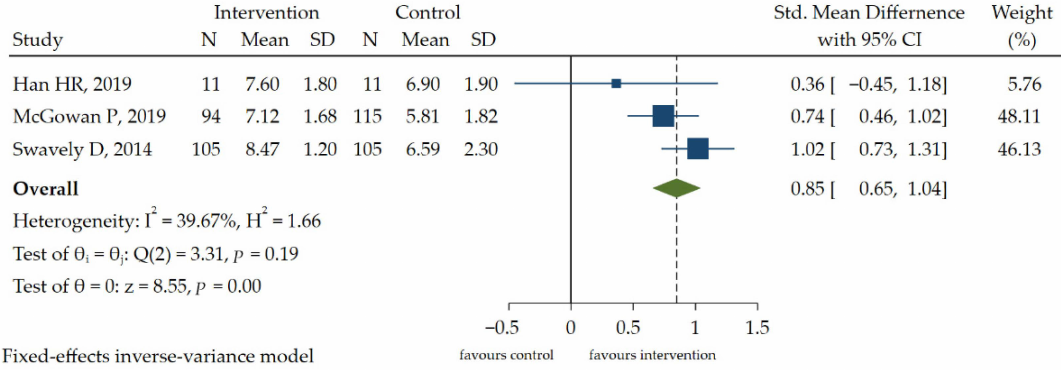
Figure 4. The forest plot of the effect of HL intervention on self-efficacy [20,23,25].